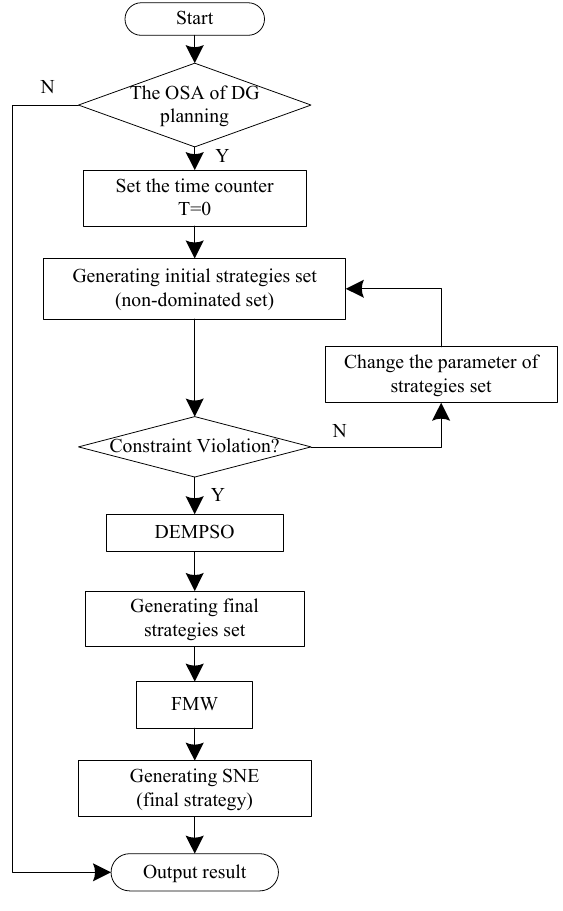
Figure 5. The flowchart of DG optimization similar mixed